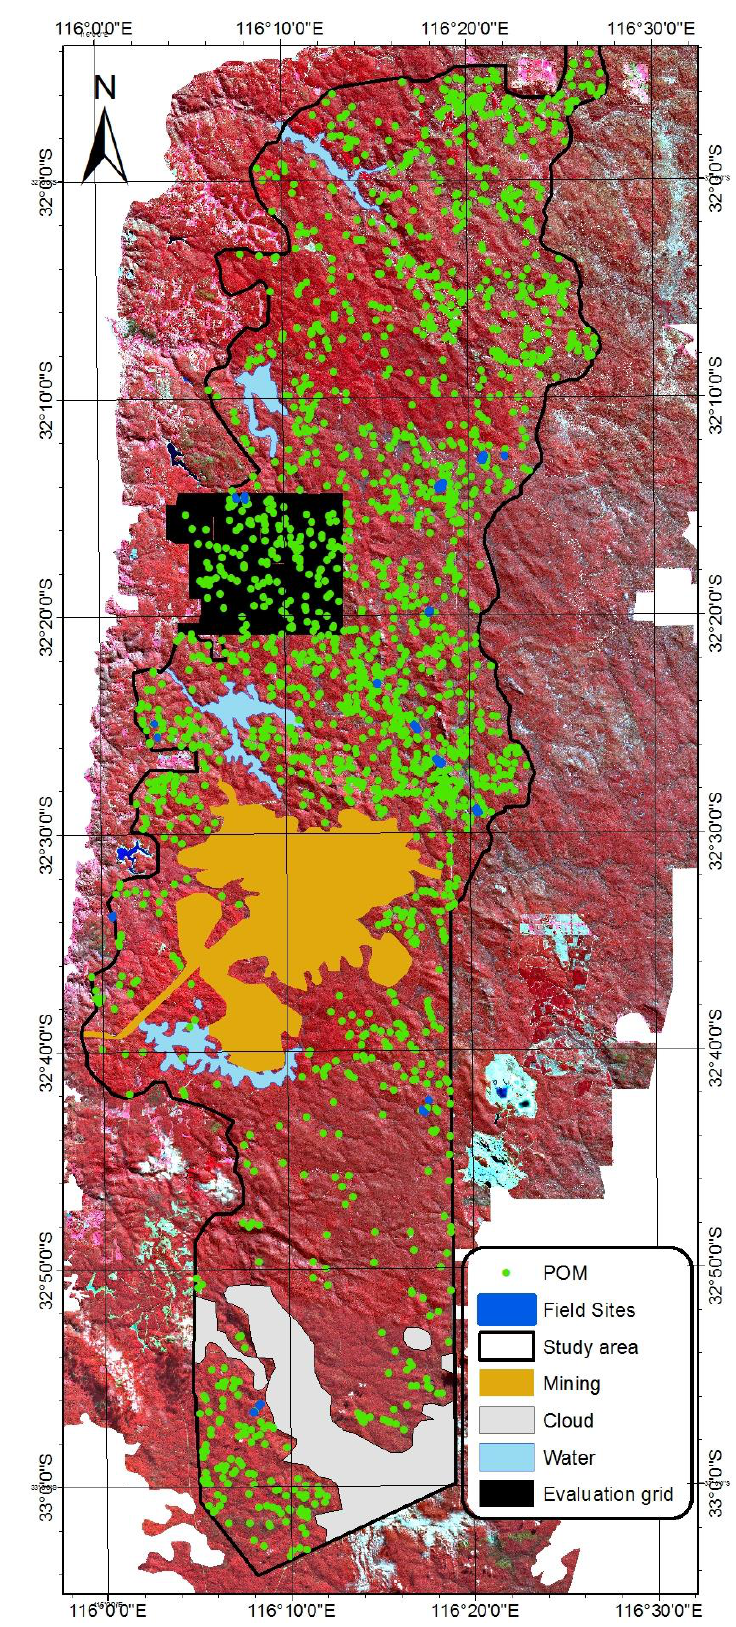
Figure 3. SPOT-5 Imagery overlaid with the mining, water and cloud masks used across the study area in modeling POM and the validation grid